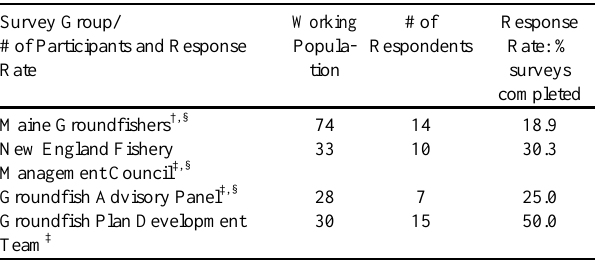
Table 1 . Survey sample size and response